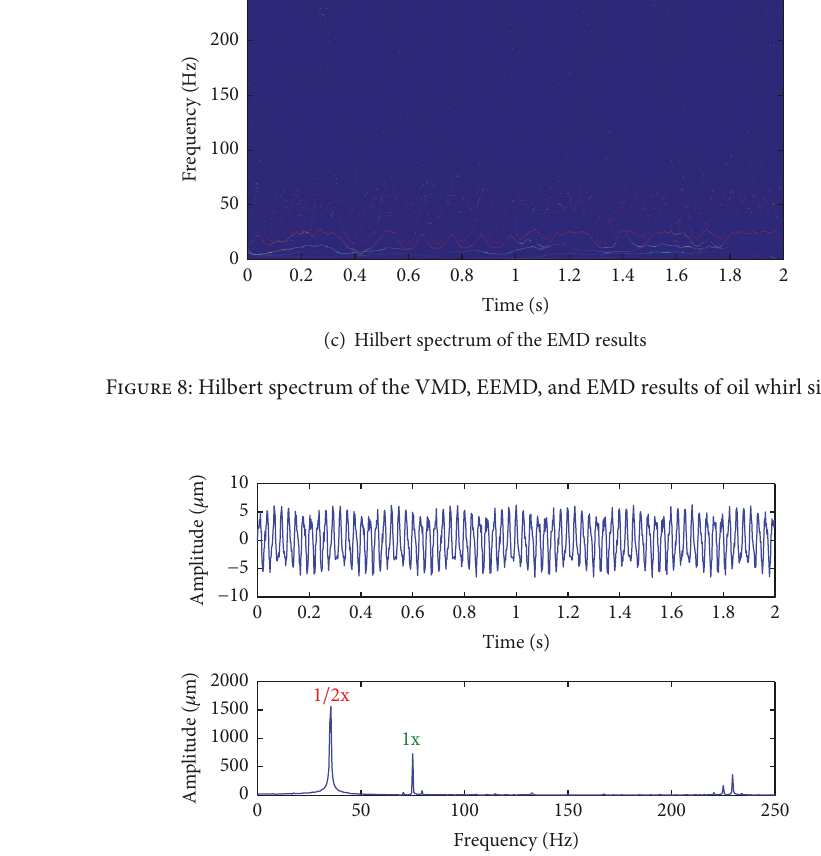
Figure 9: Time domain waveform and spectrum of oil whip